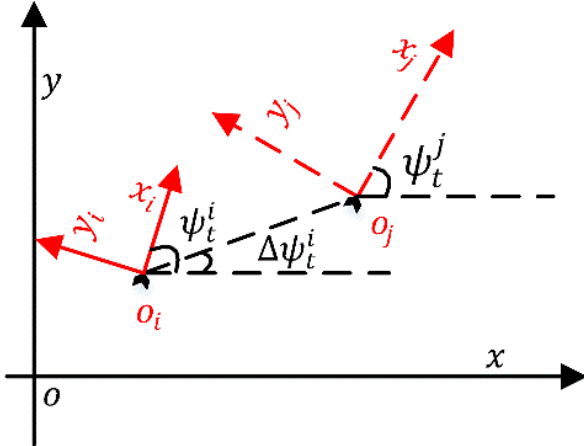
Figure 1. Coordinate transformation.